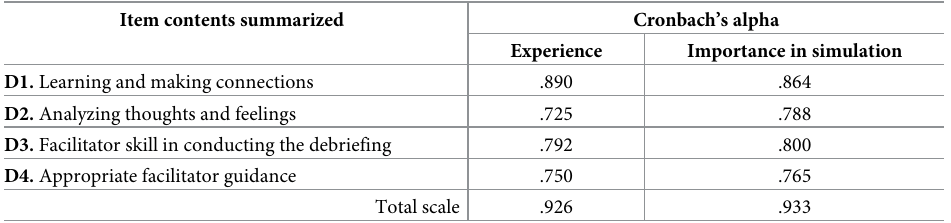
Table 3. Internal consistency coefficient Cronbach’s alpha for Debriefing Experience Scale.